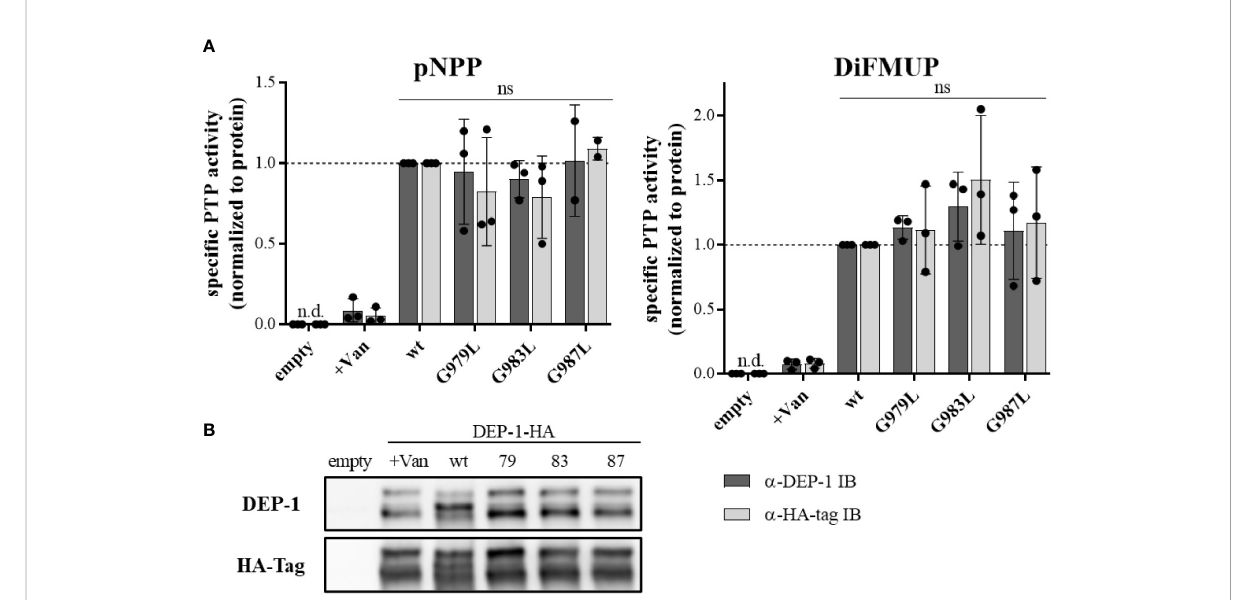
FIGURE 2 Speci fi c PTP activity of wt and TMD mutant PTPRJ remains unchanged PTPRJ-HA proteins were immunoprecipitated from transiently transfected HEK293T cells with pBABE-PTPRJ-HA constructs (wt, G979L, G983L, and G987L) 48 hours post-transfection. Cell lysates were probed with phosphatase substrate mimetics pNPP or DiFMUP for 10 – 15 min at 37°C. Vanadate was added to controls (0.2 mM, +Van) to inhibit phosphatase activity. Substrate cleavage was measured by absorbance at 405 nm (pNPP) or fl uorescence at 360/465 nm ex/em (DiFMUP). The amount of immunoprecipitated protein was analyzed by immunoblotting using antibodies recognizing PTPRJ and HA-tag. (A) Speci fi c PTP activity of PTPRJ variants relative to respective wt is shown. Values were calculated as absorbance, or fl uorescence measurements minus blank (buffer only) normalized to the amount of immunoprecipitated protein, based on quanti fi cation of PTPRJ or HA-tag immunoblots (IB). The individual values of three independent experiments (for pNPP G987L n = 2) are shown by closed circles, columns, and error bars represent mean ± standard deviation. Statistics: two-way ANOVA and Dunnett ’ s multiple comparisons test; (ns, not signi fi cant; n.d., not detectable). (B) A representative immunoblot is shown (n = 3). 79 – G979L; 83 – G983L; 87 –